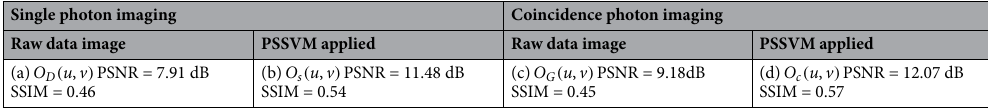
Single photon imaging Coincidence photon